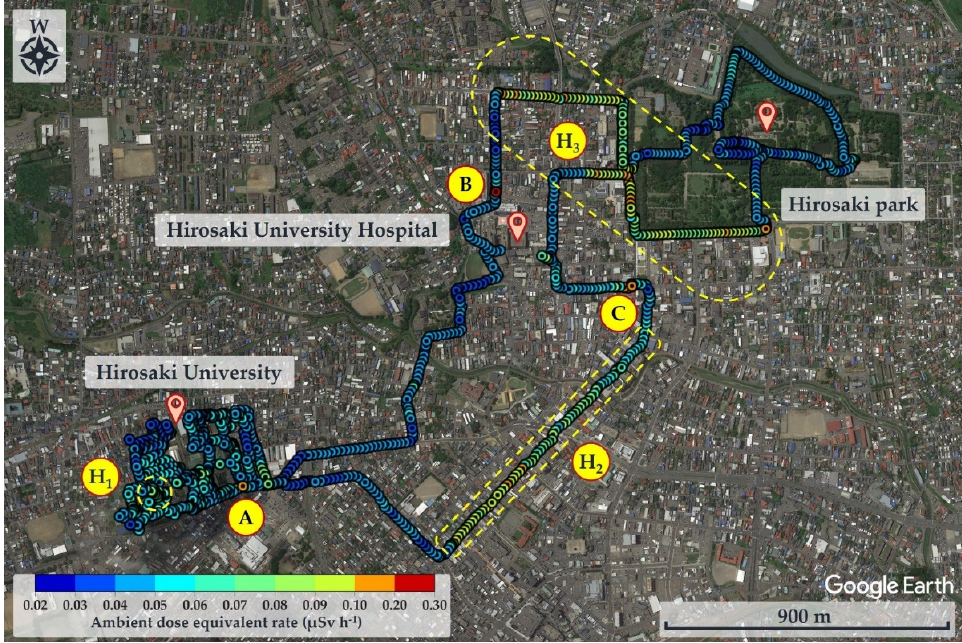
Figure 6. Distribution map of ambient dose equivalent rate in air for Hirosaki City.